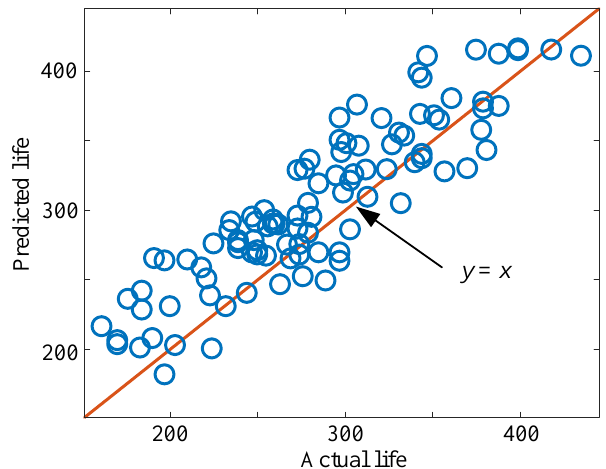
Figure 10. The predicted results of multiple samples.